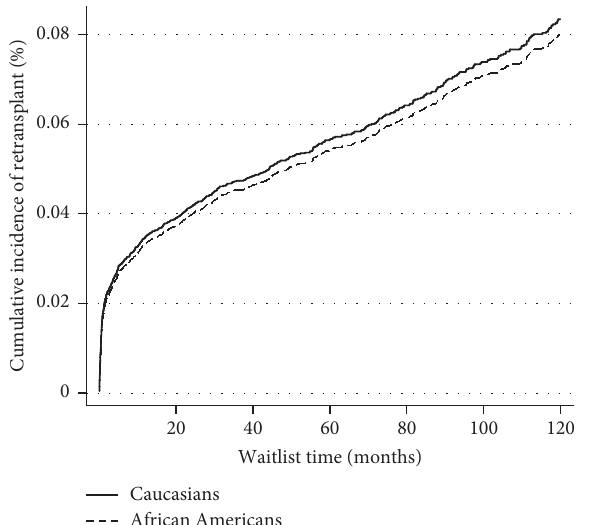
Figure 4: Competing risk analysis for cumulative incidence of retransplantation with death as competing